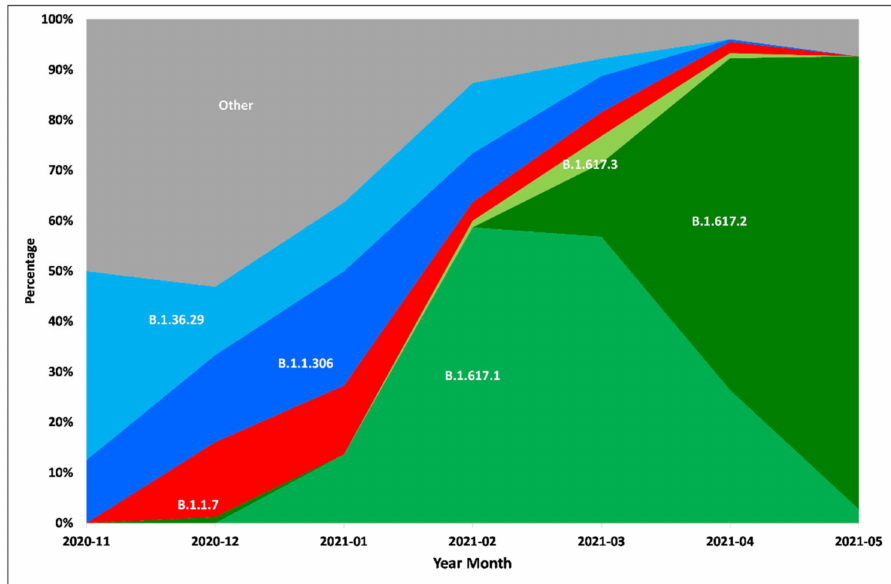
Figure 2. Temporal trend of major lineages in the districts of Maharashtra from November, 2020 to May, 2021.